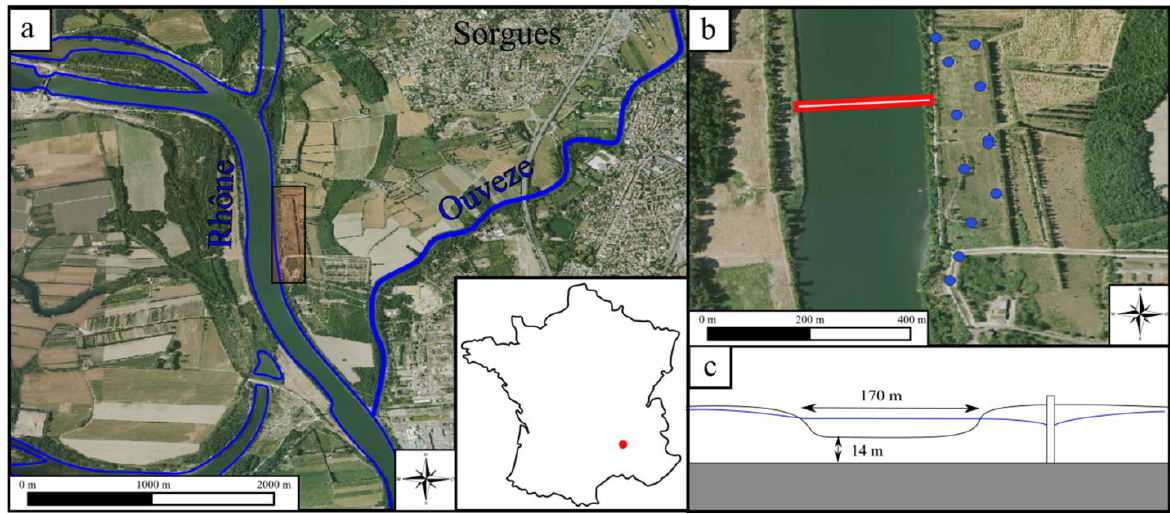
Figure 8. (a ) Geographical localization, ( b ) the position of the pumping wells field and ( c ) schematic view of the pumping field at Sorgues, France. The pumping field is located between two rivers: the Rhône and the Ouvèze that prescribe a regional head gradient. The pumping produces a local piezometric depression leading to a transfer from the surface water to the alluvial aquifer.